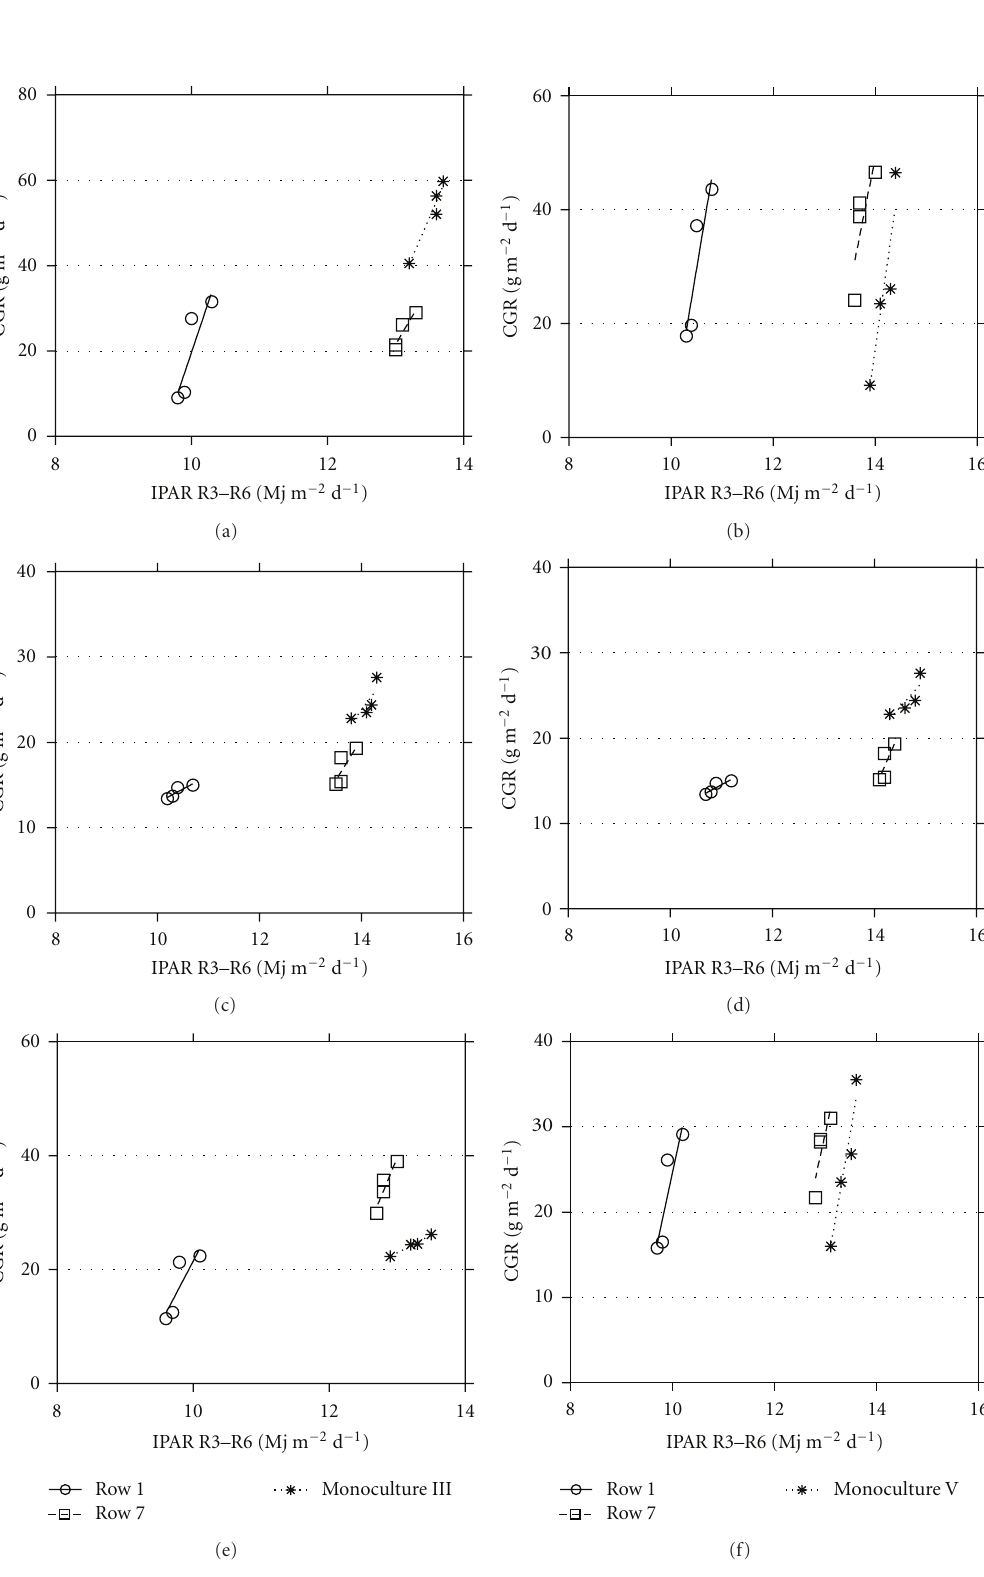
Figure 7: CGR within the period R3–R6 as a function of IPAR in the monoculture and in rows 1 and 7 of soybeans MG III-corn strips, during C1 (a), C2 (c), and C3 (e) and of soybeans MG V-corn strips, during C1 (b), C2 (d), and C3